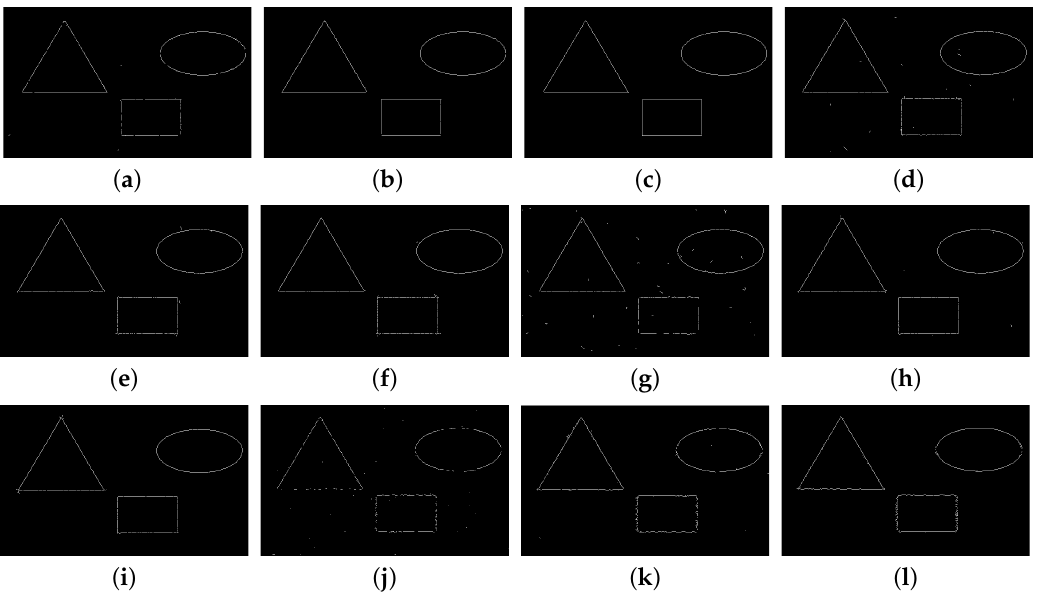
Figure 14. Edge binary maps on the simulated SAR images (Roof), from left to right is result of the one-look, three-look, and six-look simulated images. ( a – c ) SAR-PC; ( d – f ) PC; ( g – i ) Log-PC; ( j – l ) Ratio Line detector (RL).